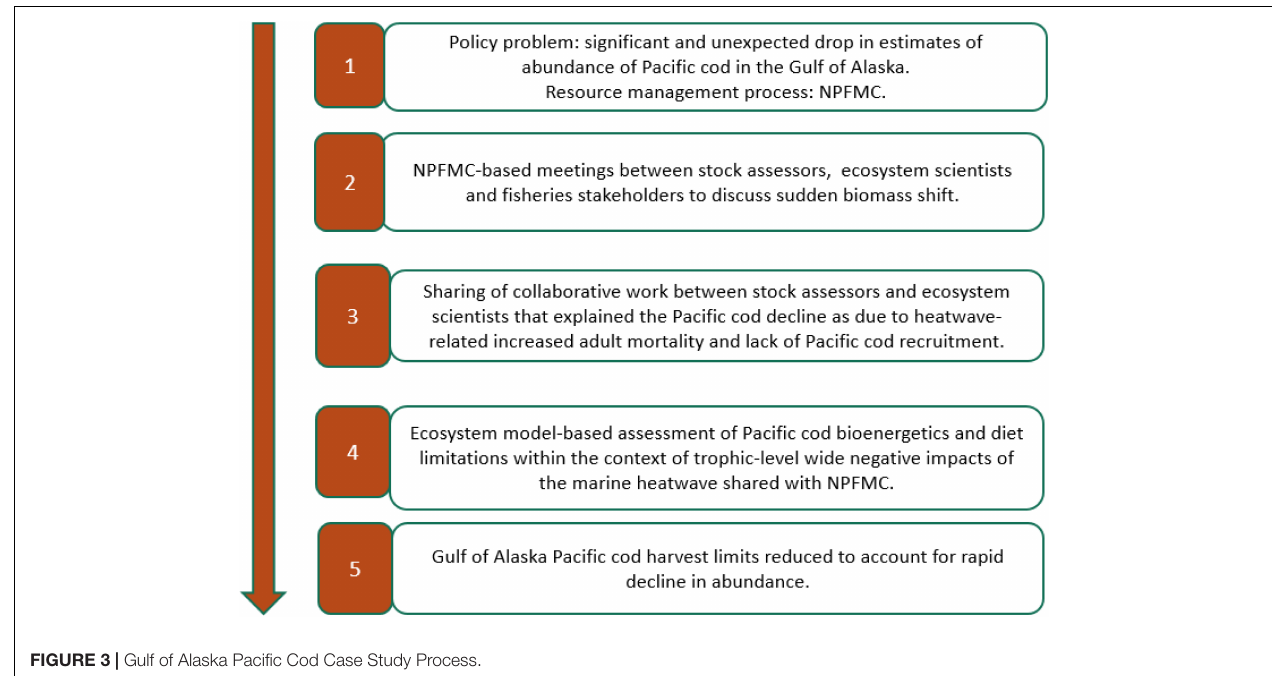
FIGURE 3 | Gulf of Alaska Pacific Cod Case Study Process.